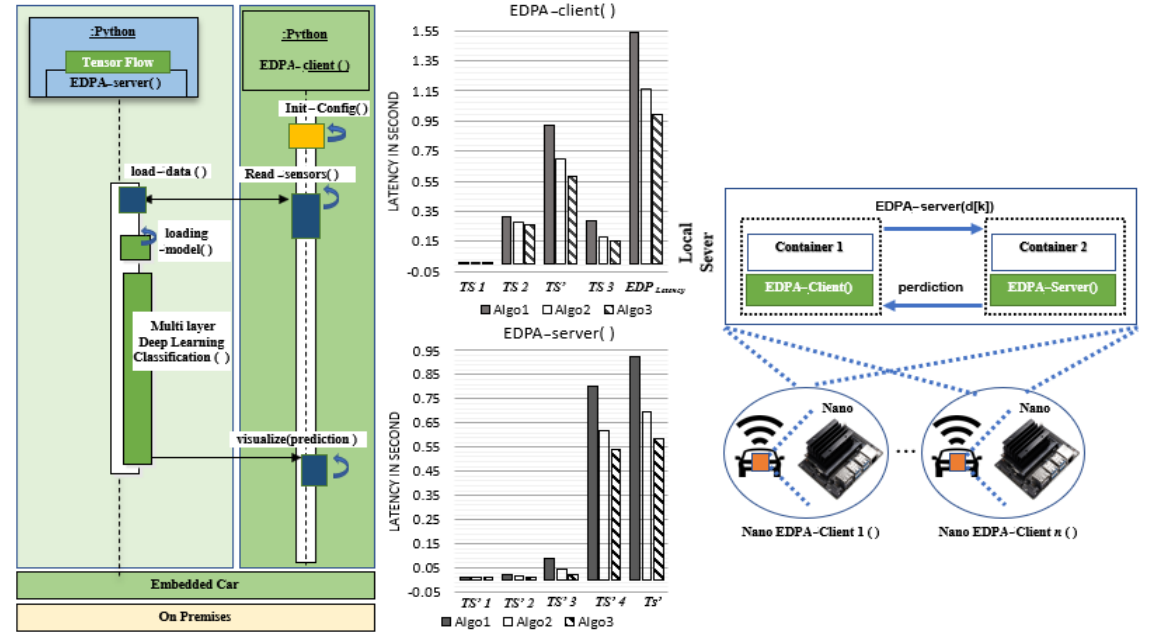
Figure 1. Existing EDPA architecture